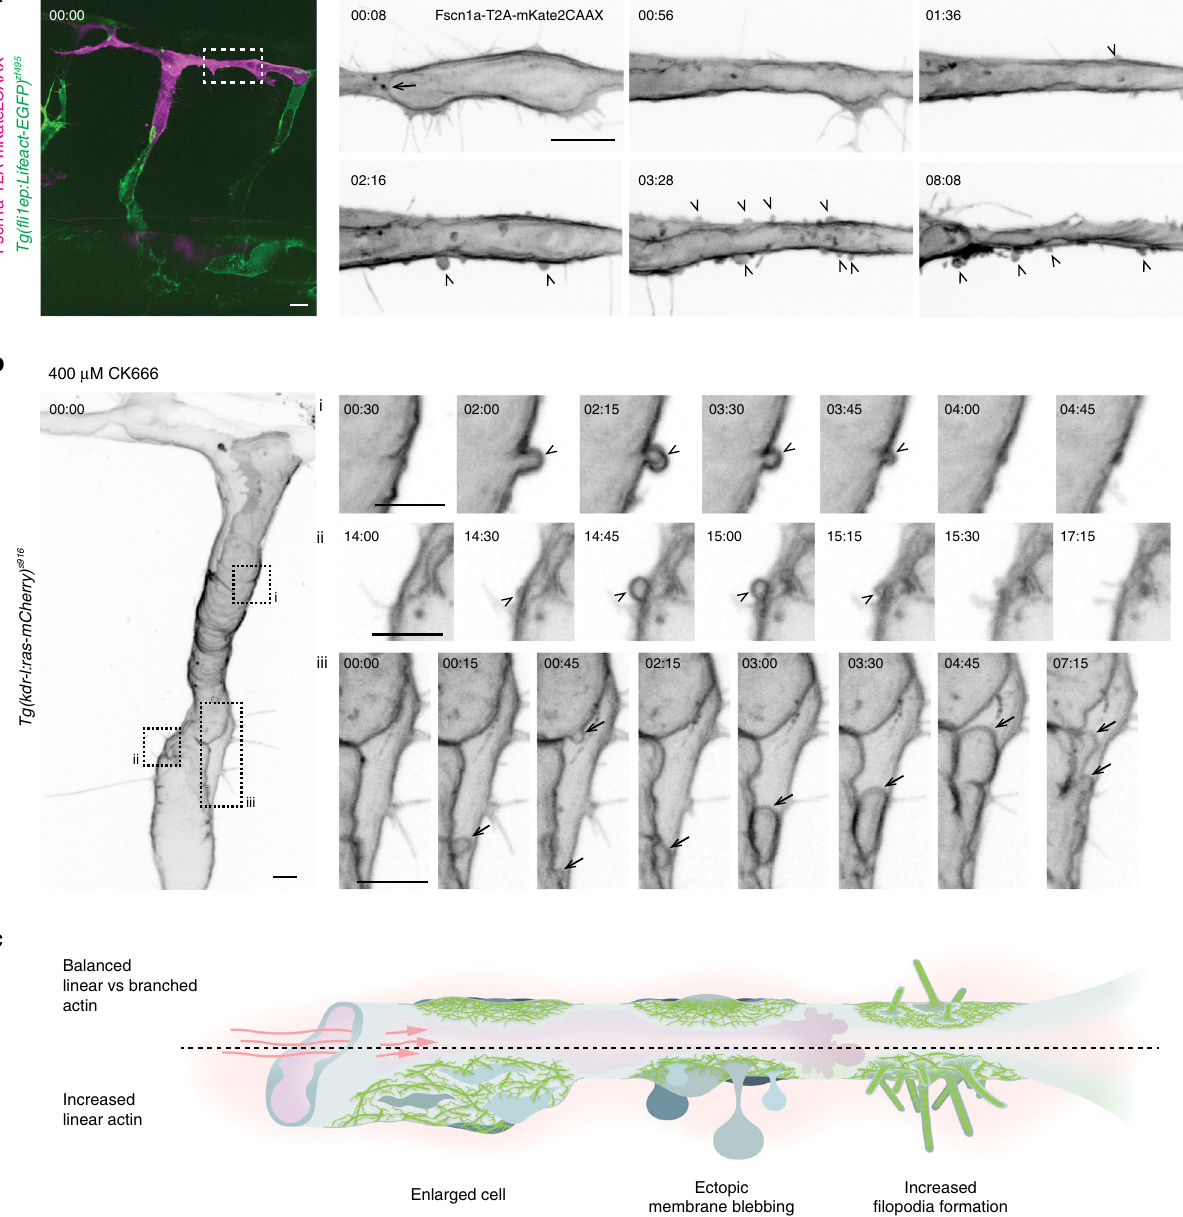
Fig. 9 Excessive formation of linear actin bundles weakens endothelial cell resistance to blood fl ow. a Endothelial-speci fi c ectopic expression of Fascin1a (Fscn1a)-T2A-mKate2CAAX (magenta) at 30 hpf. Box, region of DLAV undergoing lumenisation. Arrow, expanding apical membrane (00:08). Arrowheads, basal blebs (from 02:16). Blebbing was observed in 7 out of 8 ECs with overexpression of Fscn1a ( n = 6 embryos from two independent experiments). b Treatment of a 2 dpf Tg(kdr-l:ras-mCherry) s916 embryo with 400 µ M CK666 for 1 hour induces basal blebs (i and ii, arrowheads) and apical blebs (iii, arrow; 4 out of 4 embryos from one experiment). Boxes are observed regions. c Increase in linear actin bundle formation modi fi es EC membrane behavior and response to haemodynamic forces. 00:00, hours:minutes. Scale bars, 10 µ m ( a ) and 5 µ m ( b Quantitative real-time PCR : qPCR was performed using 1 μ L of the cDNA, generated from 150ng (HPAECs) or 500 ng (HUVECs) of total RNA, in a 10- μ L instrument in quadruplicate. Data were analyzed using the RQ Manager software (Applied Biosystems) and MARCKSL1 mRNA relative expression was calculated with the 2 − ΔΔ Ct method 47 using GAPDH as the reference gene. Whole mount in situ hybridization : Whole mount in situ hybridization was conducted according to standard protocol 48 . Embryos were fi xed in 4% PFA at 24, 48 and 72 hpf and permeabilized with 10 μ g/mL proteinase K. Hybridization was carried out in buffer [50% formamide, 5x SSC, 50 μ g/mL heparin, 500 μ g/mL tRNA (Roche) and 0.1% Tween-20] containing 5% sodium dextran sulfate (MW = 500 kDa) at 70 °C overnight. After stringency wash, the specimens were blocked with libraries were constructed using Chromium Next GEM Single Cell 3 ′ GEM, Library